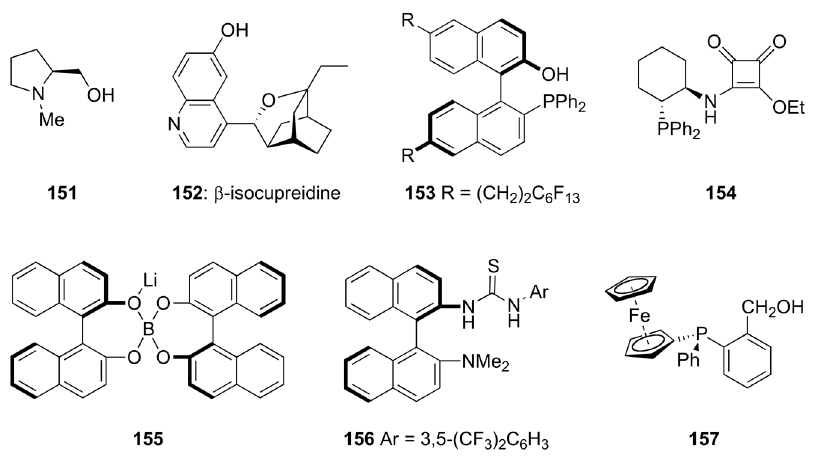
Figure 14. Chiral catalysts for enantioselective Morita–Baylis–Hillman reactions.